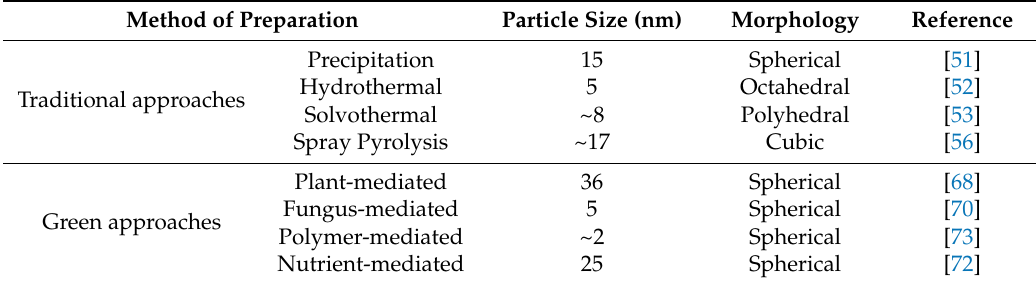
Table 1. Common methods used to synthesize cerium oxide